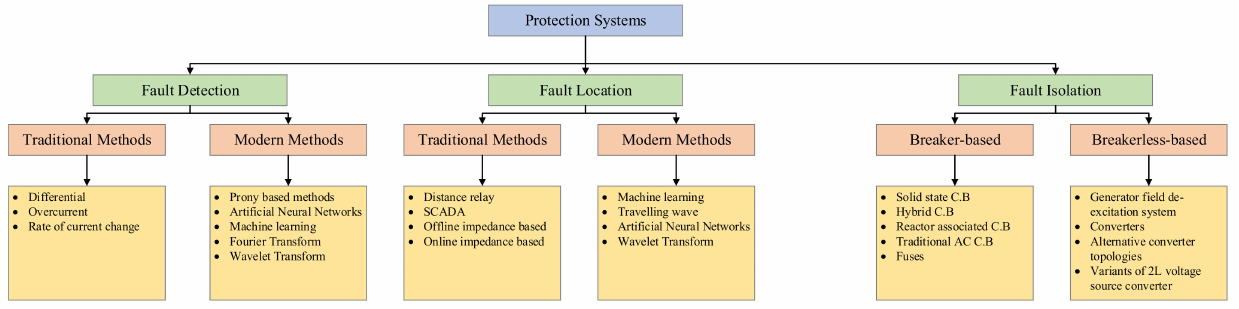
Figure 1. Overview of the protection system of DC shipboard